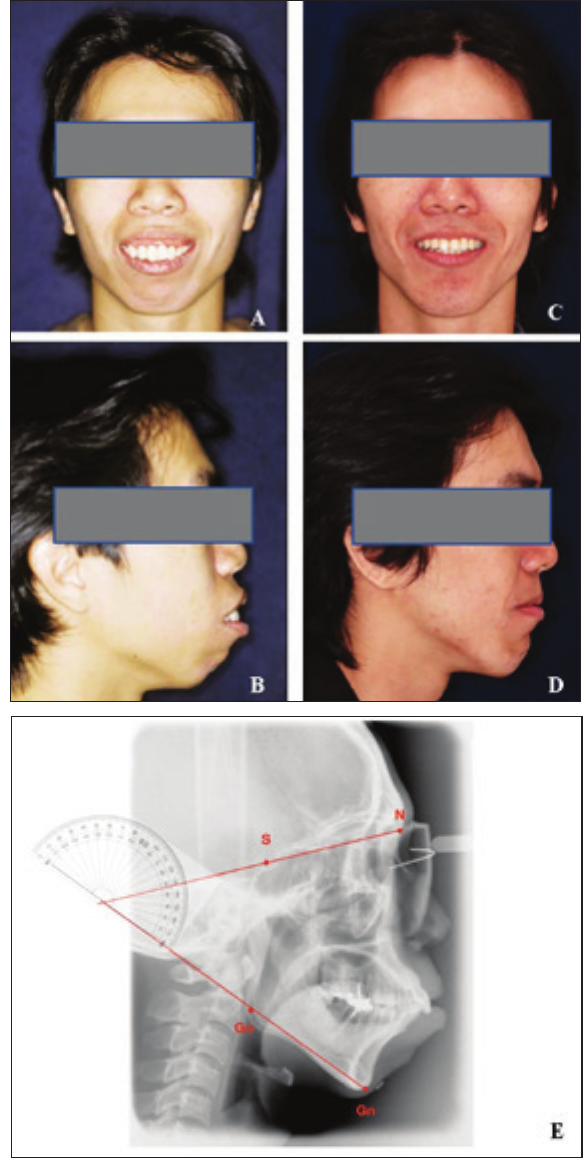
Figure 1. (A, B) The initial gummy smile resulted from vertical maxillary excess. His convex profile, longer lower thirds of face, and lip incompetence provide a clue of bone problems during extra-oral examination. (E) Cephalometric radiography is required and may reveal a steep mandibular plane and large SNGoGn degrees, which indicates that skeletal growth mainly occurs vertically. Normal SNGoGn ranges from 27 to 37 degrees. (C, D) Great improvement in skeletal relationships and gingival display are noted after orthodontic and orthognathic